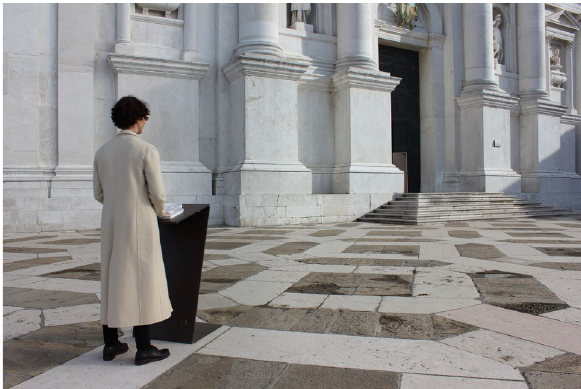
Figure 13. Accessible cultural